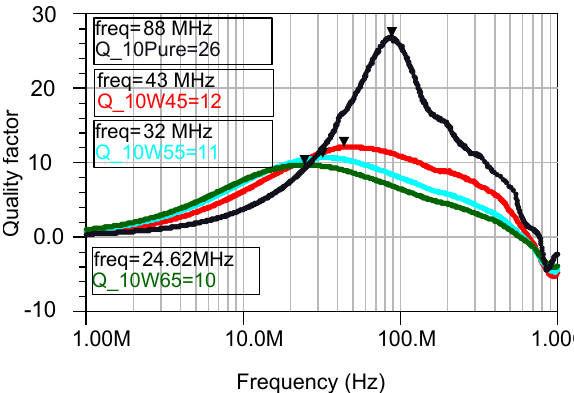
Figure 12. Quality factor of the inductors with 10 turns having cores with different percentage of the magnetic powder. The peak values of each sample and the corresponding frequency are placed in the boxes.